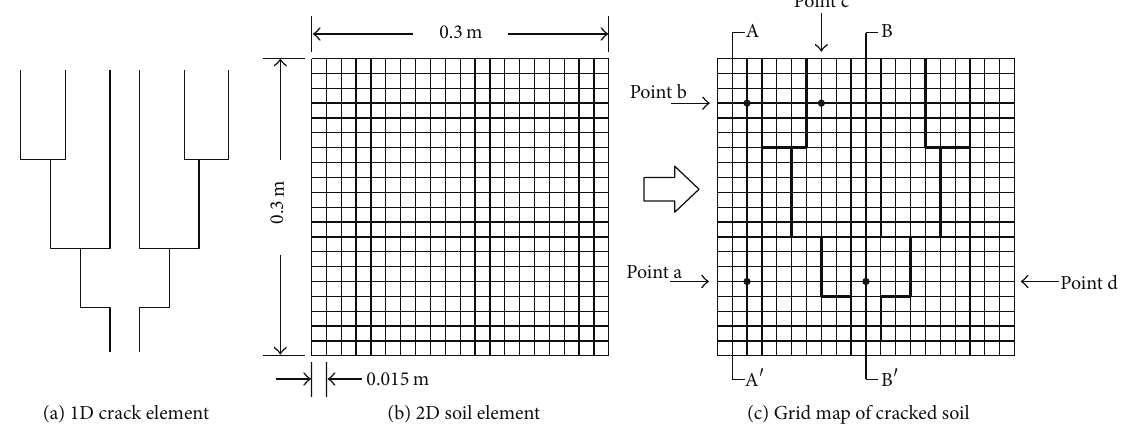
Figure 10: Grid map of computational model of soil containing cracks.